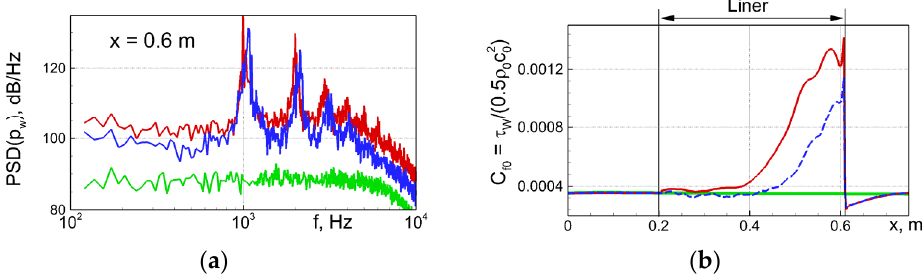
Figure 2. Effect of liner and acoustic forcing on the wall-pressure spectrum at a location close to liner’s downstream edge ( a ) and mean skin-friction distribution along duct upper wall ( b ) predicted by WMLES [13]. Green line: solid-wall duct (no liner); red: duct with liner and external forcing by plane sound waves of intensity 130 dB at f e = 1000 Hz; blue: duct with liner and without any external forcing.